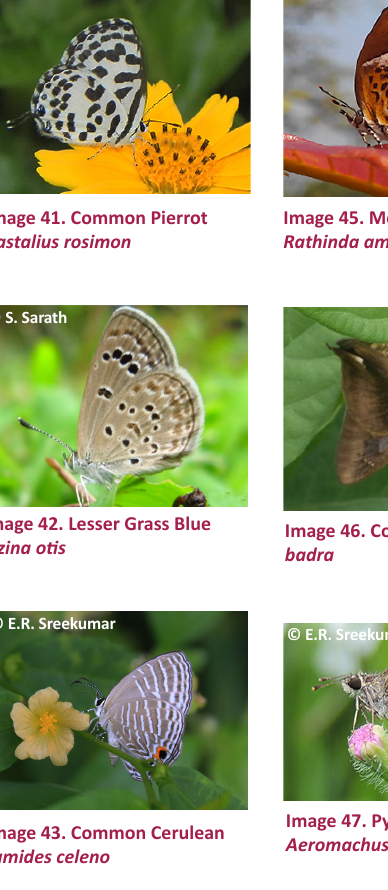
Image 51. Oriental Palm Bob Suastus gremius